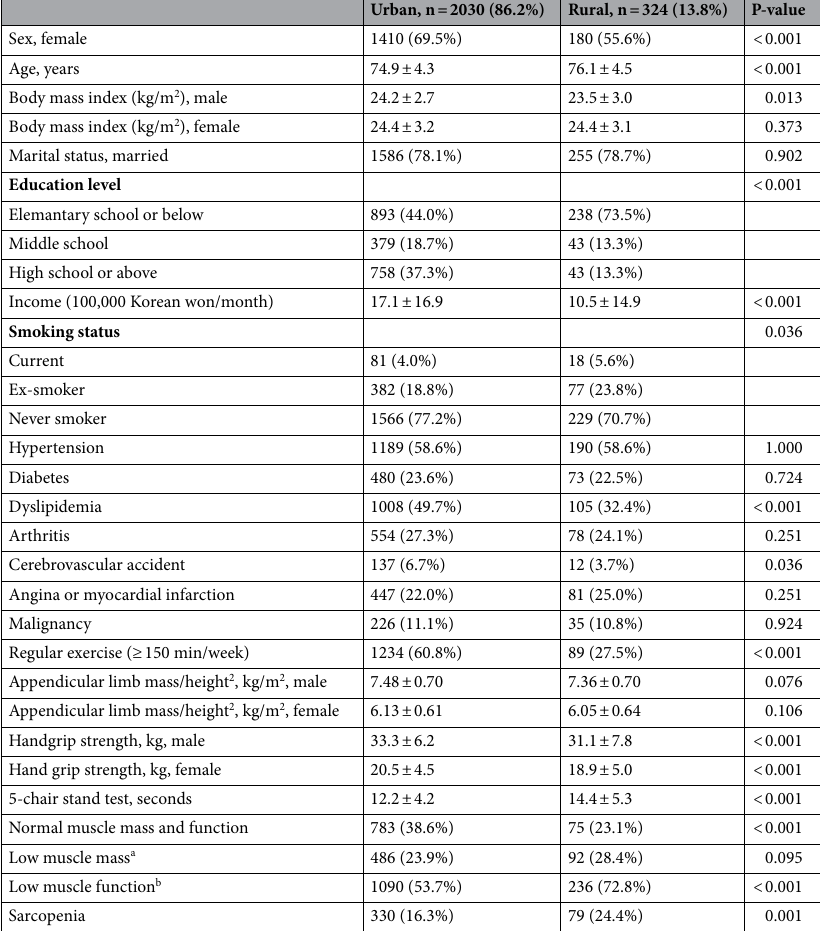
Table 1. Baseline characteristics of the participants according to the regional difference. Values are presented as numbers (% of total) or mean ± standard deviations. a Appendicular lean mass/height 2 < 5.7 kg/m 2 in females and appendicular lean mass/height 2 < 7 kg/m 2 in males. b Handgrip strength < 18 kg in females and < 28 kg in males or 5-time chair stand test > 12